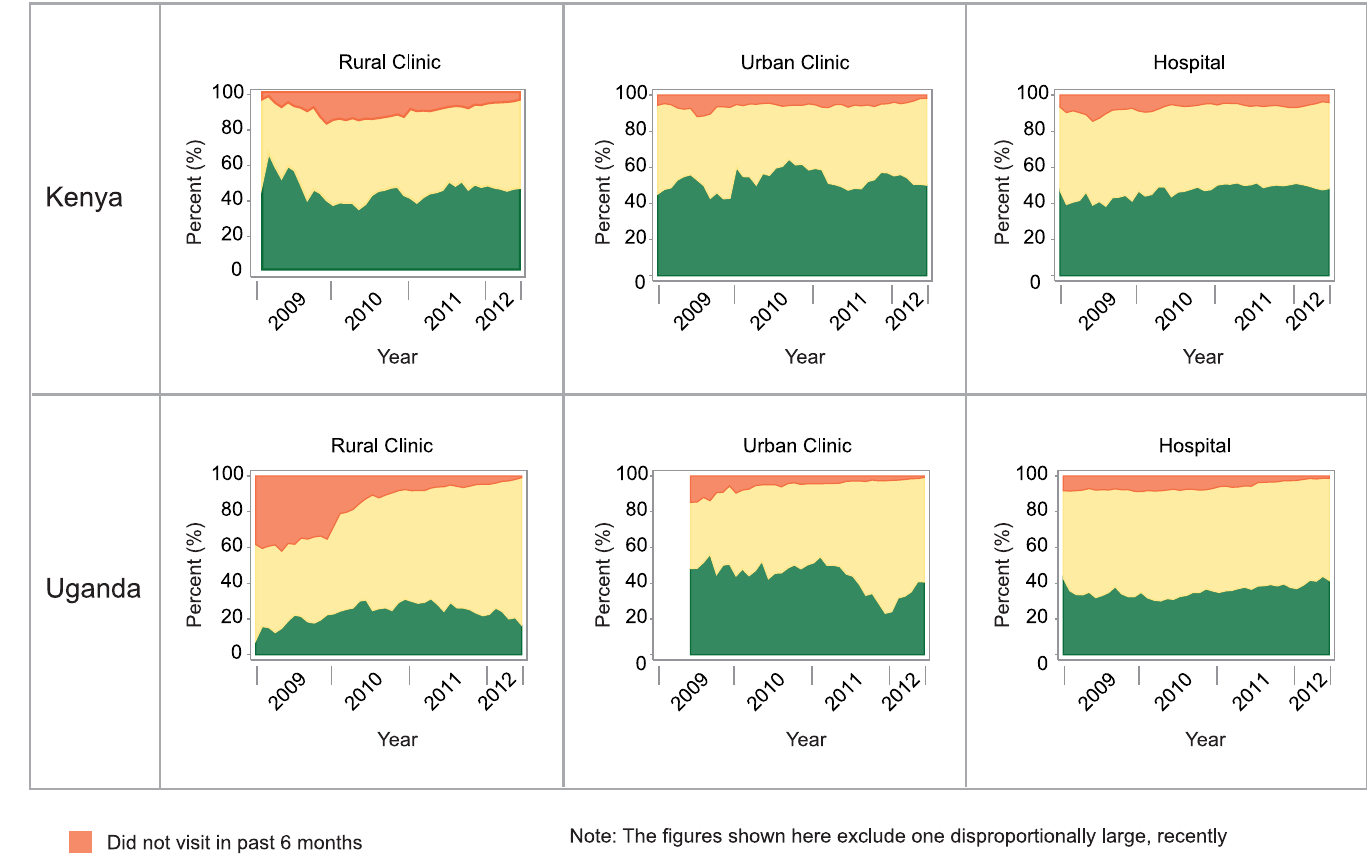
Fig 3. Percent of established patients meeting CD4 monitoring guidelines, 2009 – 2012.